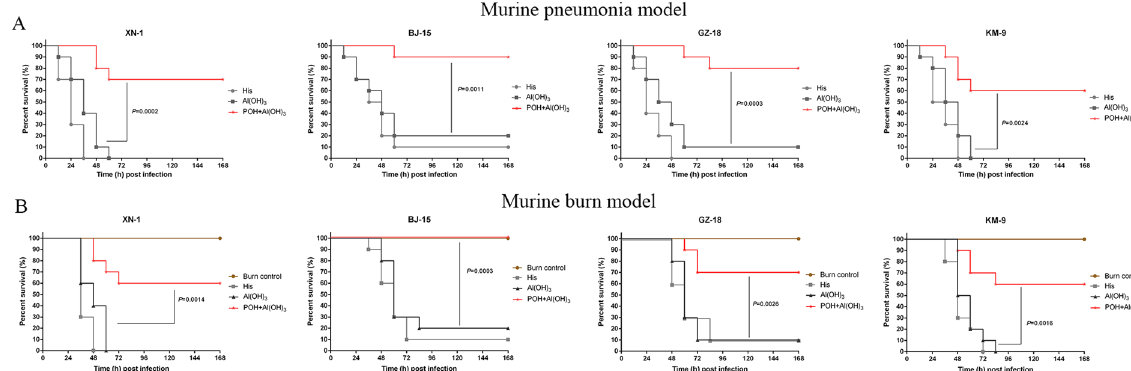
Figure 7. Mice immunized with POH broadly protected mice from different P . aeruginosa clinical strains challenge in murine pneumonia and burn models. ( A ) BALB/c mice (n = 10) immunized with POH were challenged by intratracheal injection with various P . aeruginosa clinical strains XN-1 (6.0 × 10 6 CFUs), BJ-15 (2.0 × 10 7 CFUs), GZ-18 (2.0 × 10 7 CFUs) and KM-9 (4.0 × 10 6 CFUs). Survival rates were monitored twice daily for 1 week. The Mantel-Cox log-rank test was used to compare differences between groups. ( B ) Comparison of survival rates of Al(OH) 3 -injected, POH-immunized (n = 10) mice that were challenged with burn wound infections by P . aeruginosa clinical isolates XN-1, BJ-15, GZ-18 and KM-9 (300 CFUs) at the burn site. Survival was monitored twice daily for 1 week, and the survival rates were analyzed using the log-rank test